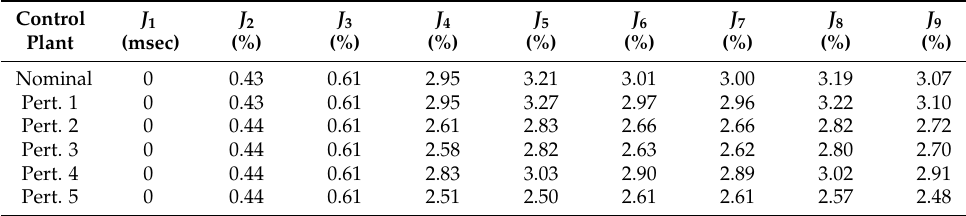
Table 8. Evaluation criteria (Damaged w/ d, El Centro earthquake, Case 2).